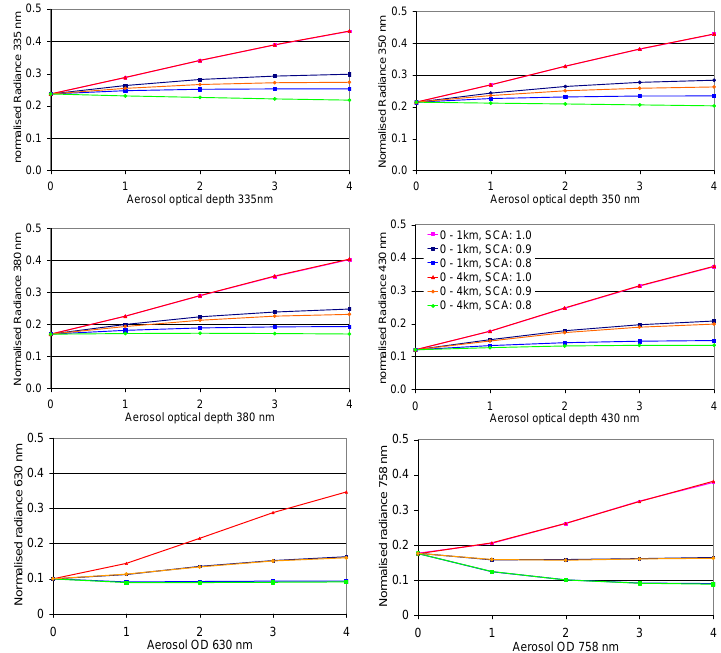
Fig. A5 Dependence of the normalised radiance on the AOD. The calculations are performed for SZA of 30° and a viewing angle of -90° (nadir geometry). The aerosol asymmetry parameter was assumed to be 0.68. For 758 nm the surface albedo was set to 20%, for 630 nm to 10%, and for all other wavelengths to 5%.